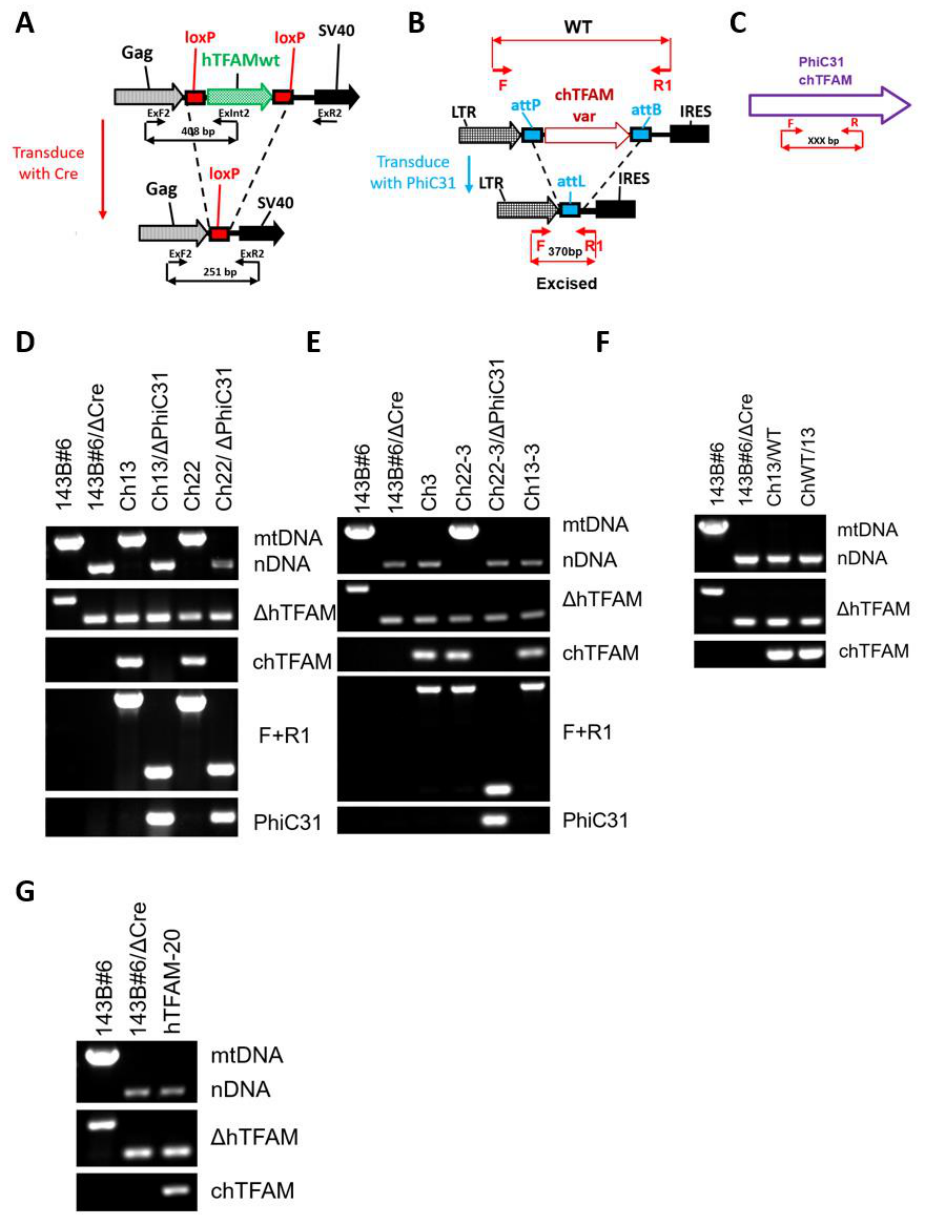
Figure 3. TFAM residues making DNA contacts are critical for mtDNA replication. ( A–C ) PCR genotyping strategies. ( A ) PCR genotyping strategies for excision of hTFAM ( ∆ hTFAM). ( B ) Genotyping of excision of modified chTFAM (chTFAMvar, F + R1 panel). ( C ) Genotyping of PhiC31 and chTFAM (PhiC31 and chTFAM panels, respectively). mtDNA, nDNA, duplex PCR with two pairs of primers for the detection of hmtDNA; ( D ) Both Ch13 and Ch22 TFAM variants support the replication of hmtDNA. ( E ) Ch22-3 variant supports hmtDNA replication, whereas Ch3 and Ch13-3 variants do not. ( F ) Neither Ch13/WT nor ChWT/13 support the replication of hmtDNA. ( G ) hTFAM with “chicken” DNA contact residues does not support the replication of the